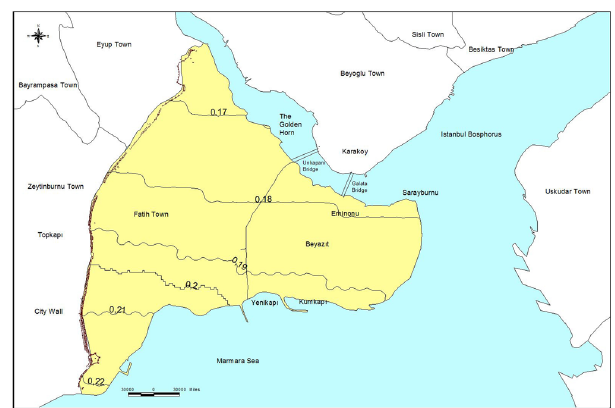
Fig. 11. The PGA contour map for a 40% probability of exceedance in 50yr for the